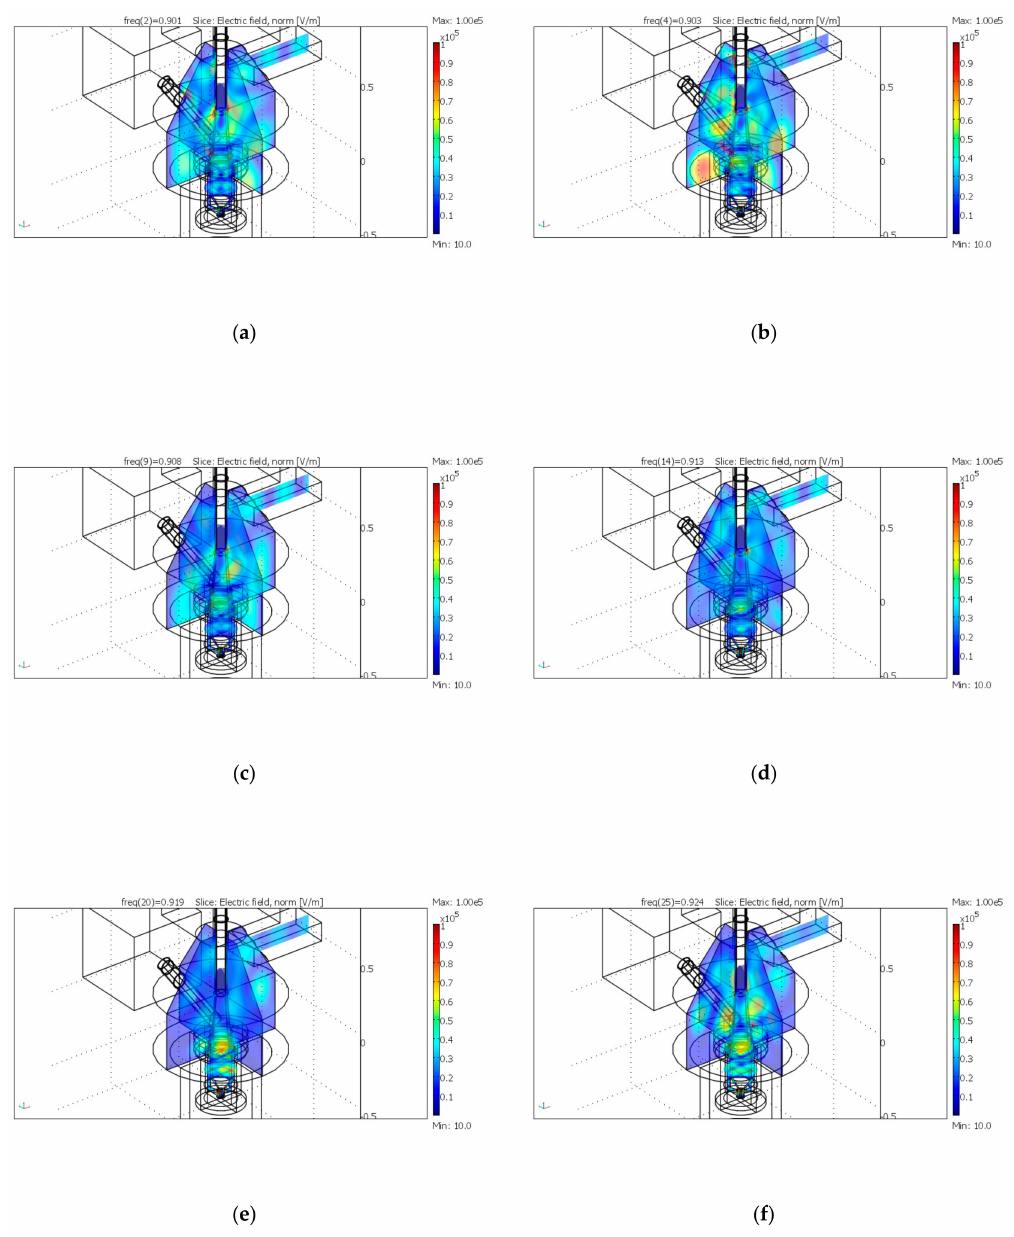
Figure 8. Electric field strength distribution in the applicator at the frequency of: ( a ) 901 MHz; ( b ) 903 MHz; ( c ) 908 MHz; ( d ) 913 MHz; ( e ) 919 MHz; ( f ) 924